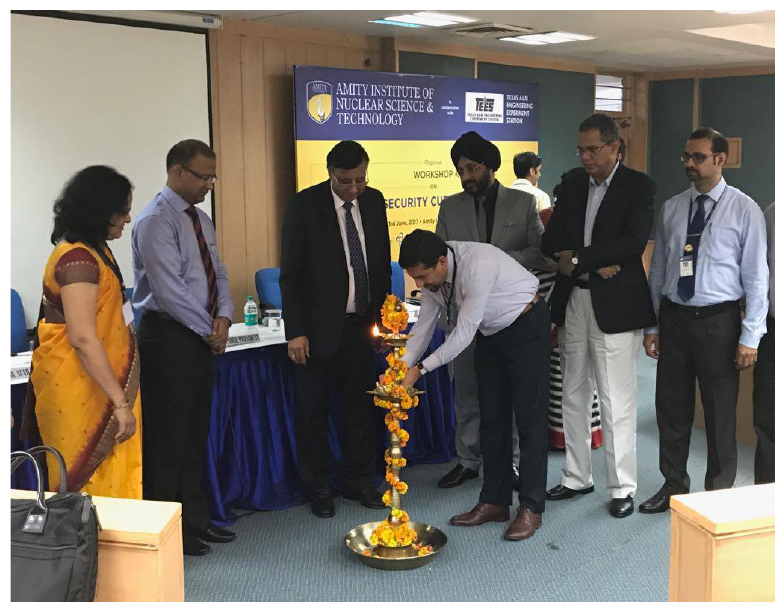
Picture 1. Lighting of lamp ceremony during inauguration in the Nuclear Security Curriculum Review workshop, 2017 at